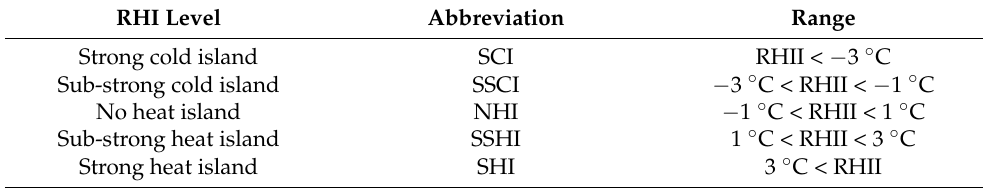
Table 2. Grade classification of regional heat island intensity.